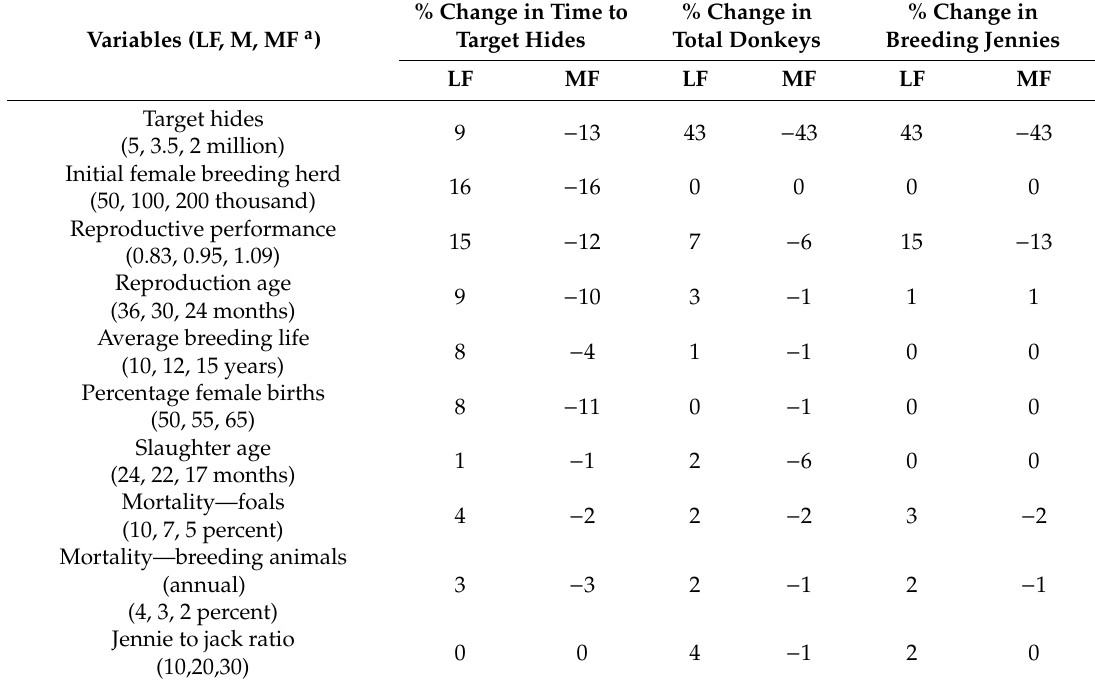
Table 4. Percentage change in time to reach target hides, total donkeys and breeding jennies compared to middle scenario using less and more favourable values for individual